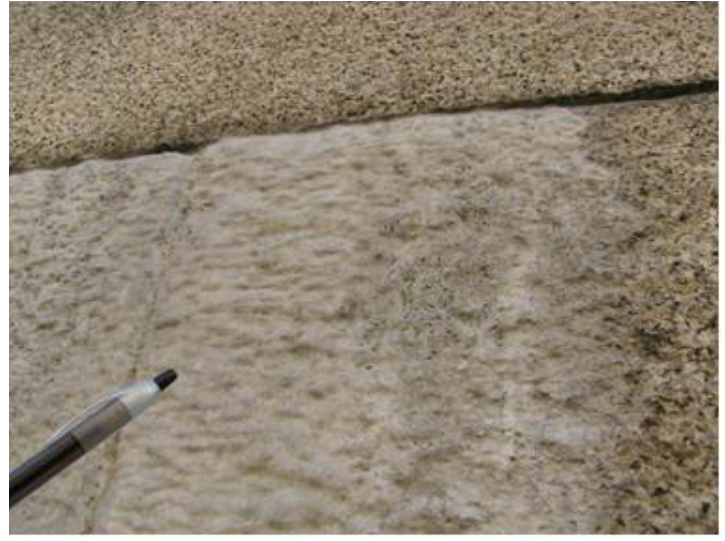
Figure 5. Example of carbonate crusts on granite